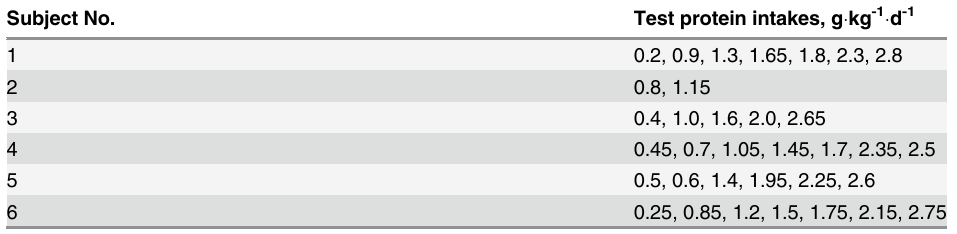
Table 1. Protein intakes used in individual subjects. Participants consumed each protein intake which ranged from 0.2 to 2.8 g (cid:1) kg -1 (cid:1) d -1 , for a total of 34 trials. Subject